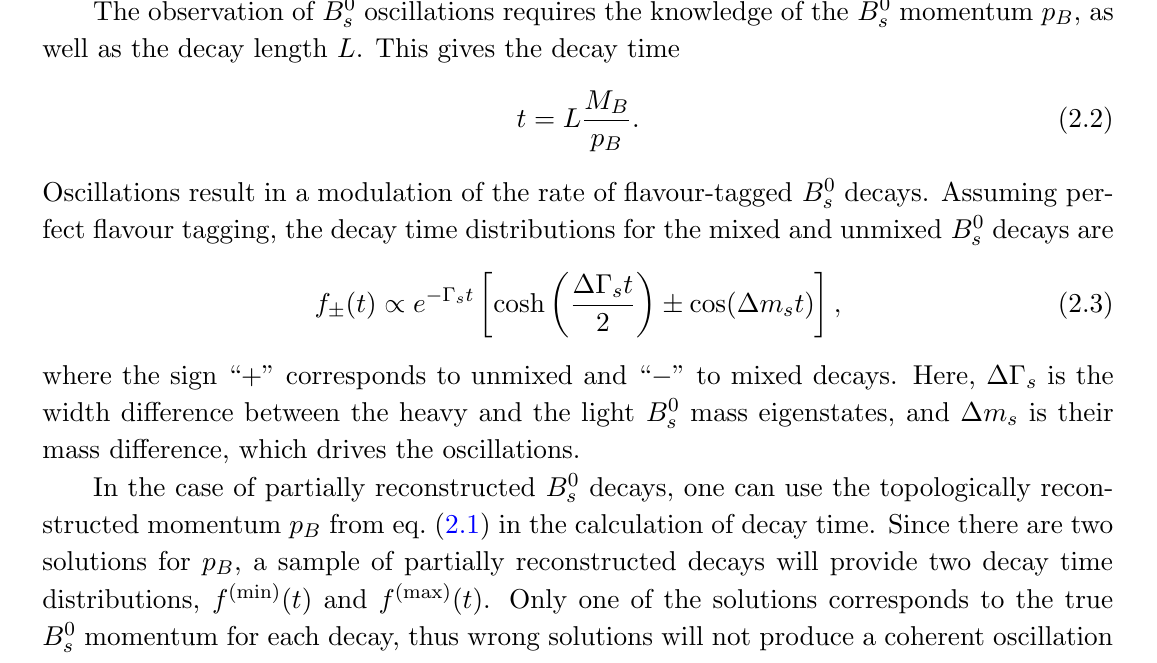
Figure 2 . Logarithms of the magnitudes of the reconstructed momentum p B of the B 0 as functions of the momentum p A of the reconstructed state A of mass 2 GeV for the di(cid:11)erent angles (cid:18) and masses m X of the invisible state X . The p B solutions for each value of p A are plotted following eq.